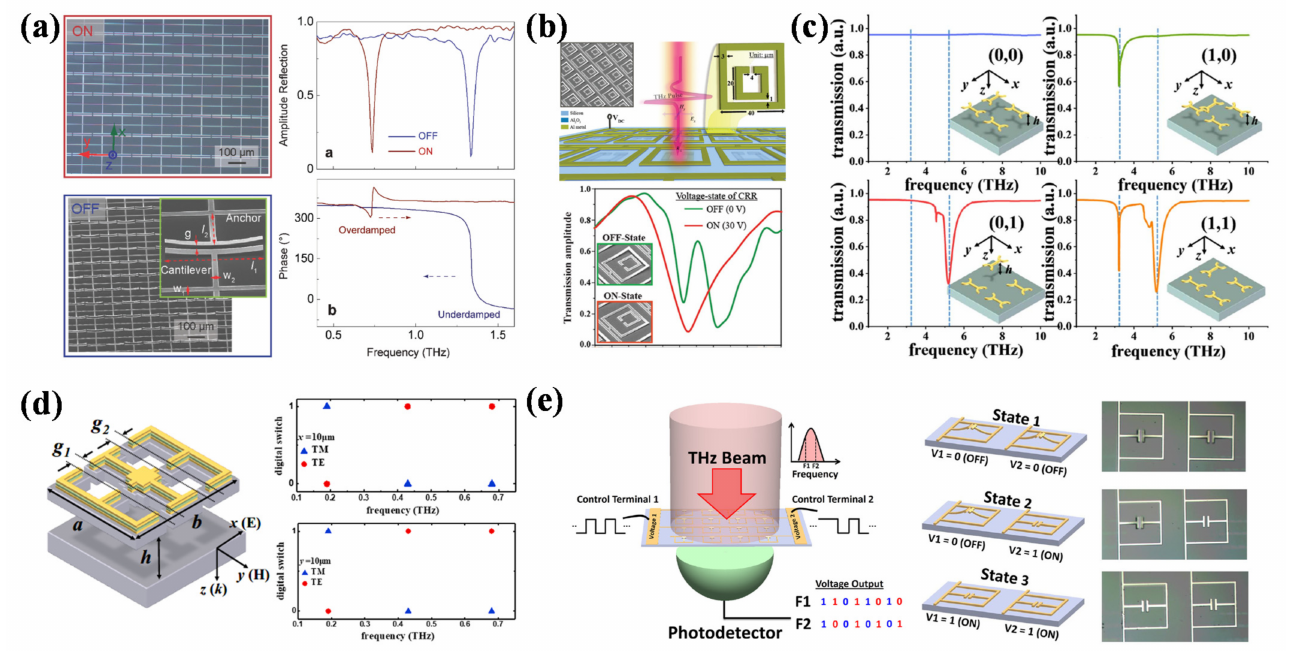
Figure 8. MEMS-based metamaterial for logic operation. ( a ) The “on” and “off” states microscopic images of the MEMS-based metamaterial array [105]. The reflection amplitude spectra and the phase spectra of the MEMS-based MIM metamaterial operating in the “on” and “off” states. ( b ) Schematic of the MEMS-incorporated composite reconfigurable metamaterial structure consisting of outer MEMS CRR and the inner SRR [106]. THz transmission spectra of the composite MEMS-metamaterial device without and with the driving voltage across the metal lines and the silicon substrate. ( c ) Programmable metamaterial using the WSM configuration for (0, 0), (1, 0), (0, 1), and (1, 1), respectively [107]. ( d ) Schematic of eSRR, which can logically switch the digital signals as (0, 1) and (1, 0) at different polarization states and switch the digital signals as (0, 0) and (1, 1) by moving the central bar along the x- and y -axis, respectively [108]. ( e ) Schematic of the proposed binary coded digital metamaterial for the control of output intensities at specific frequencies to provide the analogous logic outputs